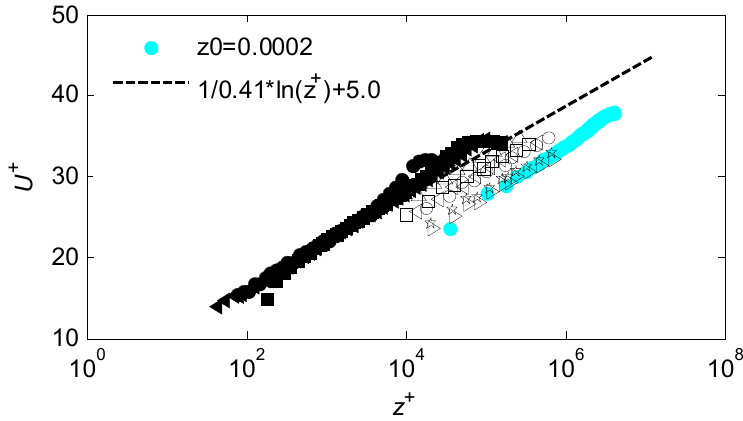
Figure 2. Comparison of mean velocity profiles. The solid colored symbols indicate current simulation data; the black dashed line indicates U + = ln ( z + ) /0.41 + 5.0 for a smooth-wall wind profile; the black open upward-facing triangles show Surface layer Turbulence and Environmental Science Test (SLTEST) field measured data, Re τ = 6.28 × 10 5 ; the solid black circles indicate the Melbourne wind tunnel experiment data, Re τ = 1.801 × 10 4 ; the solid black squares represent the William B. Morgan Large Cavitation Channel experiment data acquired by the US Navy, Re τ = 6.867 × 10 4 ; the solid black leftward-facing triangles show the Princeton Superpipe experiment data, Re τ = 9.819 × 10 4 , the observational and experimental data obtained by Marusic et al. [33]; the open symbols present the QLOA field-measured data from Wang and Zheng [9]; the black open squares show Re τ = 1.63 × 10 6 ; the black open circles represent Re τ = 2.19 × 10 6 ; the black open leftward-facing triangles give Re τ = 2.95 × 10 6 ; the black open rightward-facing triangles provide Re τ = 3.14 × 10 6 ; and the black open stars show Re τ = 4.19 × 10 6 .